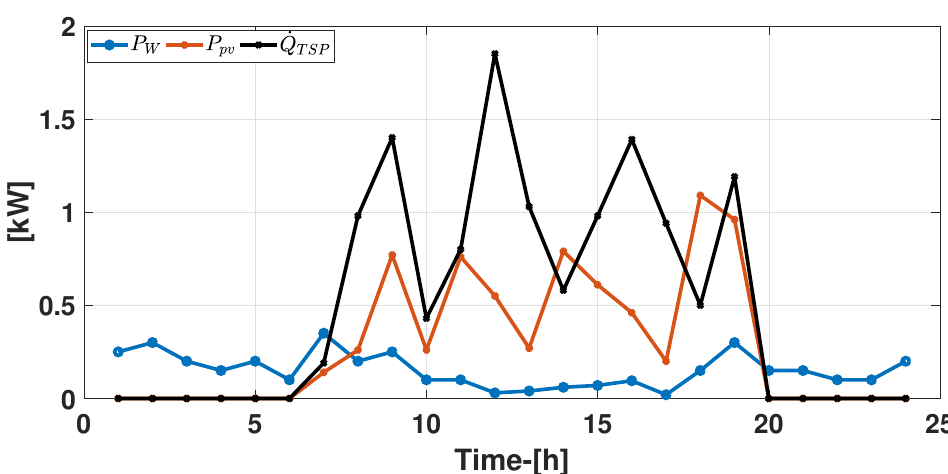
Figure 11. Thermal and electric power generation for Example 2.